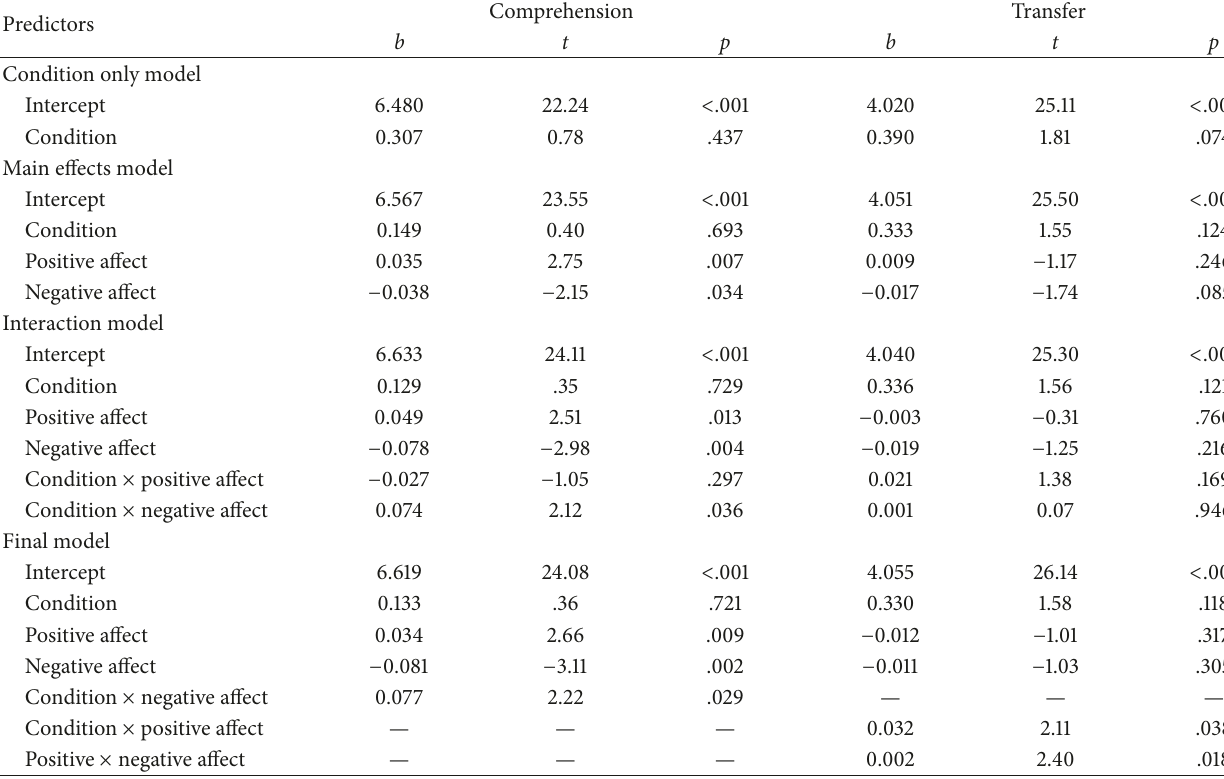
Table 2: Regression of performance after learning (i.e., comprehension and transfer) on condition and positive and negative affect measured before learning (𝑁 = 111) .